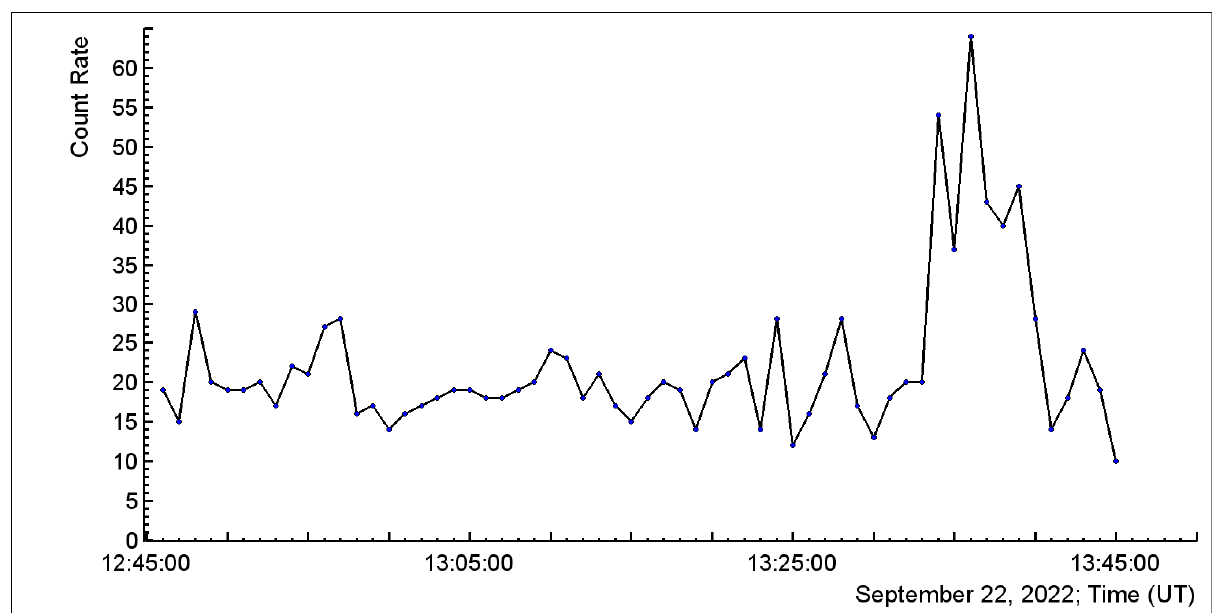
Figure 11. 1-minute time series of count rate of coincidences of 2 identical 1 m 2 plastic scintillators and NaI(Tl) detector located in Nor Amberd.